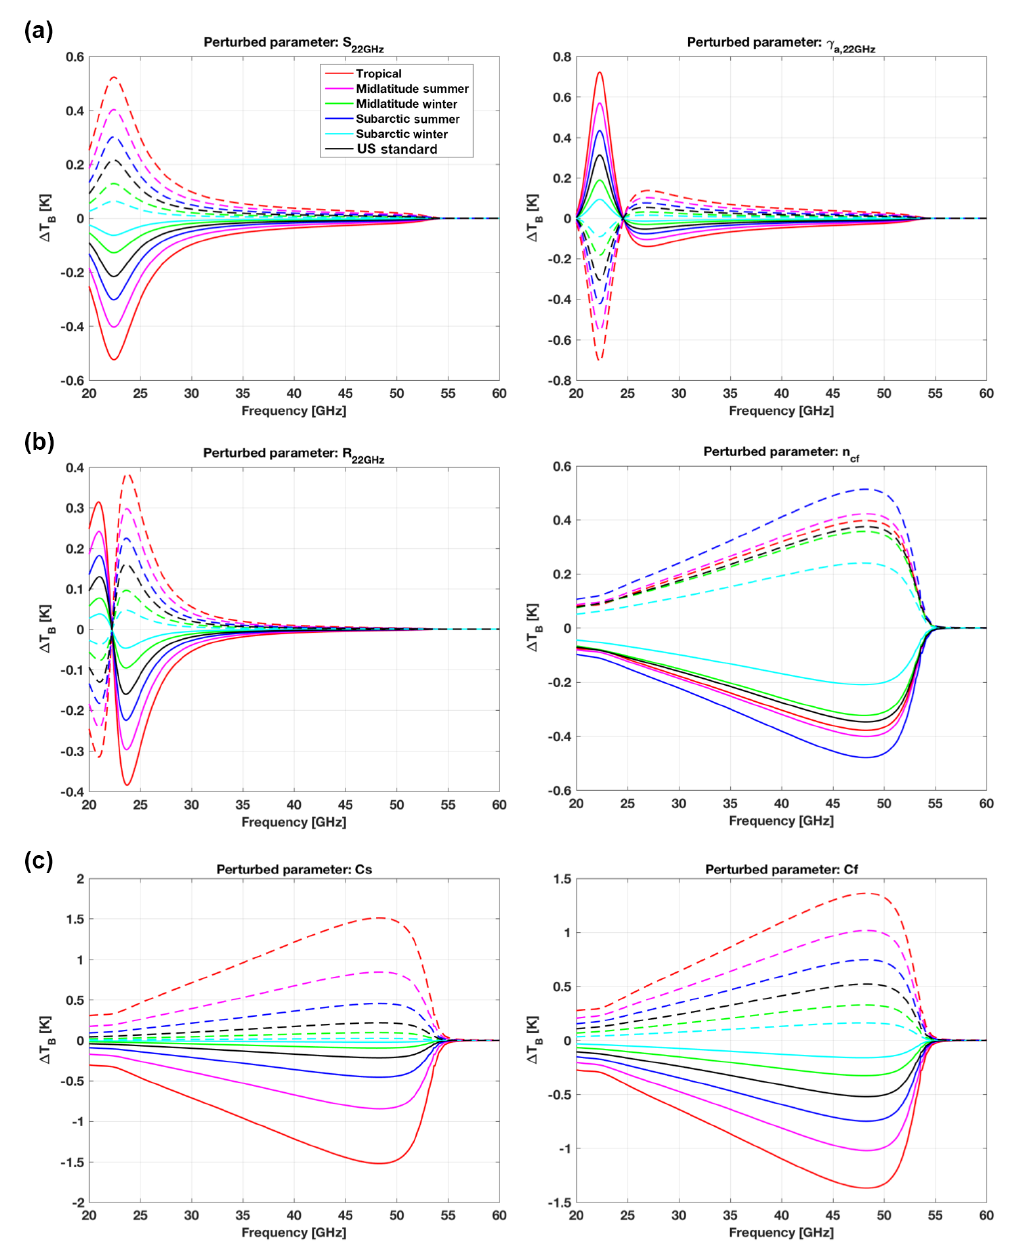
Figure 2. Sensitivity of modeled T B to water vapor absorption parameters. (a) Line intensity ( S i ) and air broadening ( γ i, a ) at 22GHz. (b) Shift-to-broadening ratio ( R i ) at 22GHz and foreign-broadening temperature-dependence exponents ( n cf ). (c) Self-induced ( C s ) and foreign-induced ( C f ) broadening coefficients. Solid lines correspond to negative perturbation (value − uncertainty), while dashed lines cor- respond to positive perturbation (value +